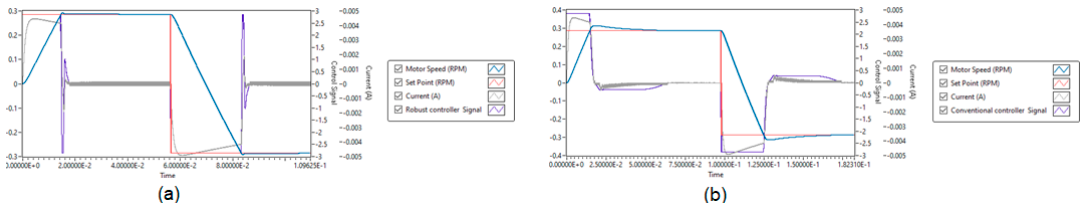
Figure 3. Robust controller ( a ) and conventional Proportional-Integral-Derivative (PID) controller, ( b ) dynamic speed response in Per Unit system (P.U.) when speed reference is 0.27 P.U. time in seconds.